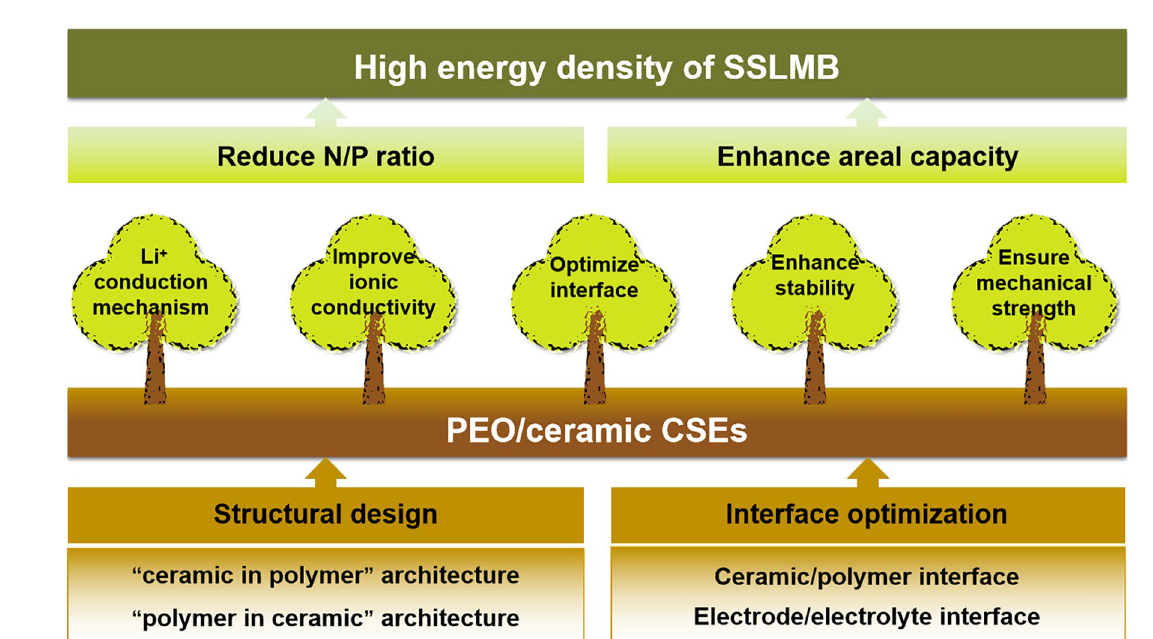
Fig. 16 Schematic illustration of significant challenges and strategies to achieve excellent